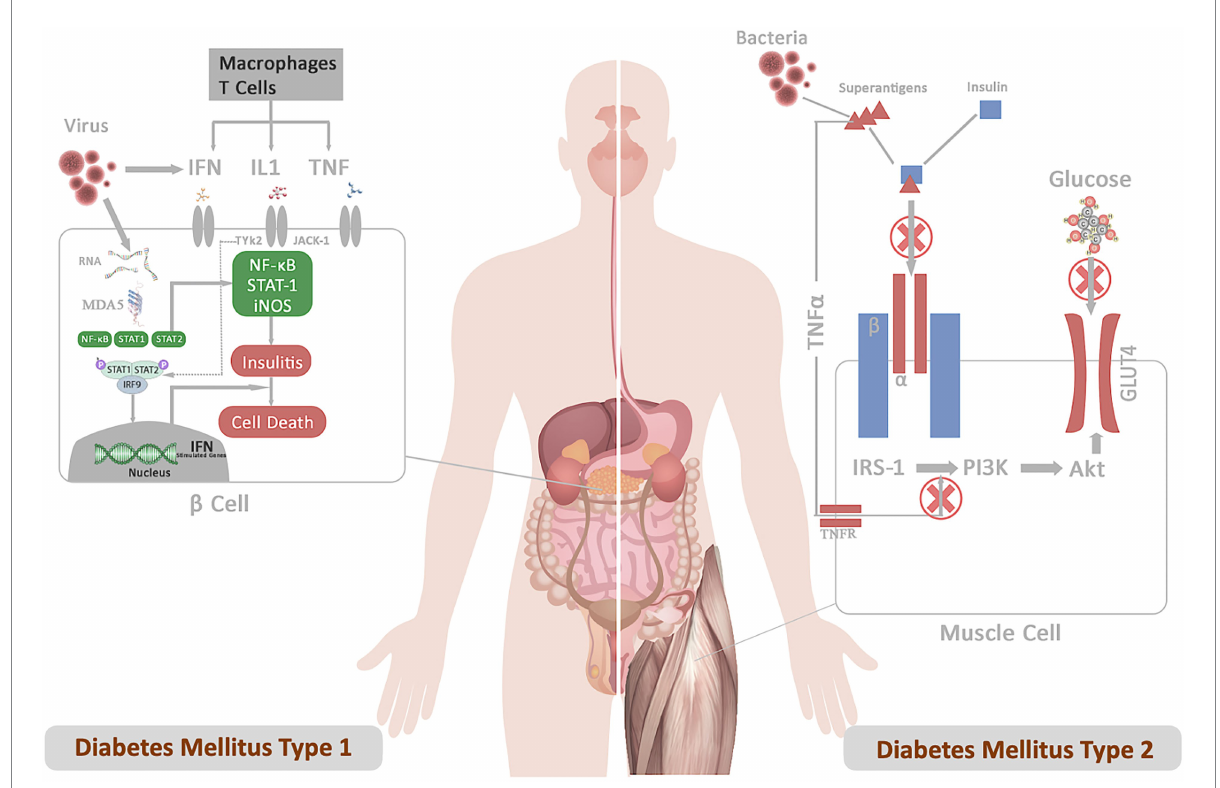
FIGURE 1 Represents the mechanistic of diabetes infection emphasizing the role of infection in DM1 and DM2 pathogenesis. (A) DM1: Following the infection, viral particles release viral RNA in the host cells, which is recognized by the cytoplasmic receptor MDA5. The binding of MDA5 to the RNA activates the transcription factors NF- κ B and STATs pathway. The binding of IFN, IL, and TNF to their receptors results in the activation of the JAKs and TYK2 pathway, triggering activation of STAT-1–STAT-2–IFN-regulatory factor 9 complex. These complexes translocate to the nucleus and bind IFN-stimulated response elements in DNA to initiate the transcription of genes involved in host defense. Production of type I interferons contributes to insulitis and cell death. (B) DM2: Superantigens secreted from bacterial pathogens ( S. aureus ) (a) prevent insulin binding to the IR and abrogate signal transduction (b) LPS-stimulated inflammatory cytokine block PI3 kinase-Akt pathway. These signals inhibit downstream IR signaling events involved in promoting glucose conversion, reducing recruitment of the glucose transporter GLUT4 to the cell membrane, and impairs glucose